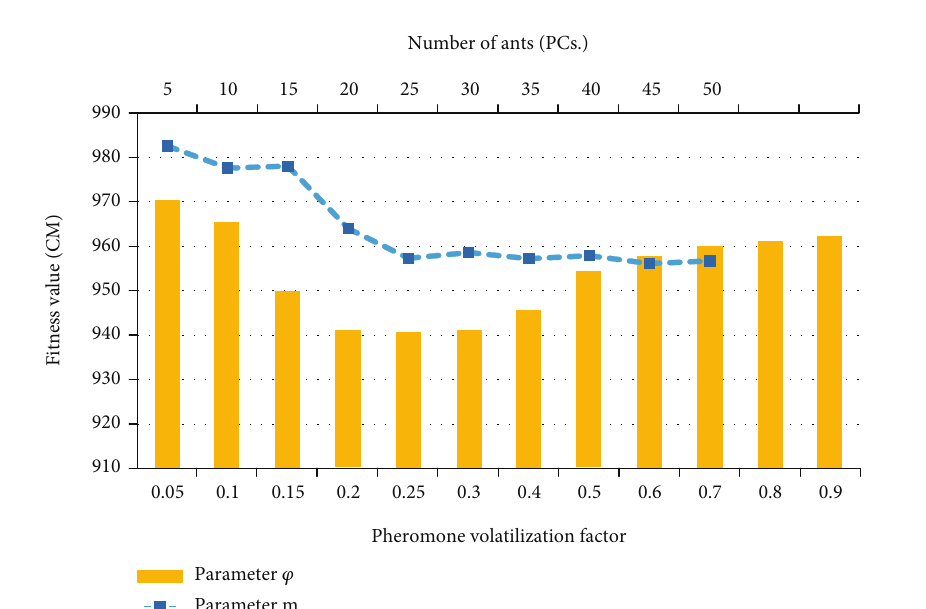
Figure 4: The in fl uence of ant number and pheromone volatilization factor on the target result of the optimization ant colony algorithm.